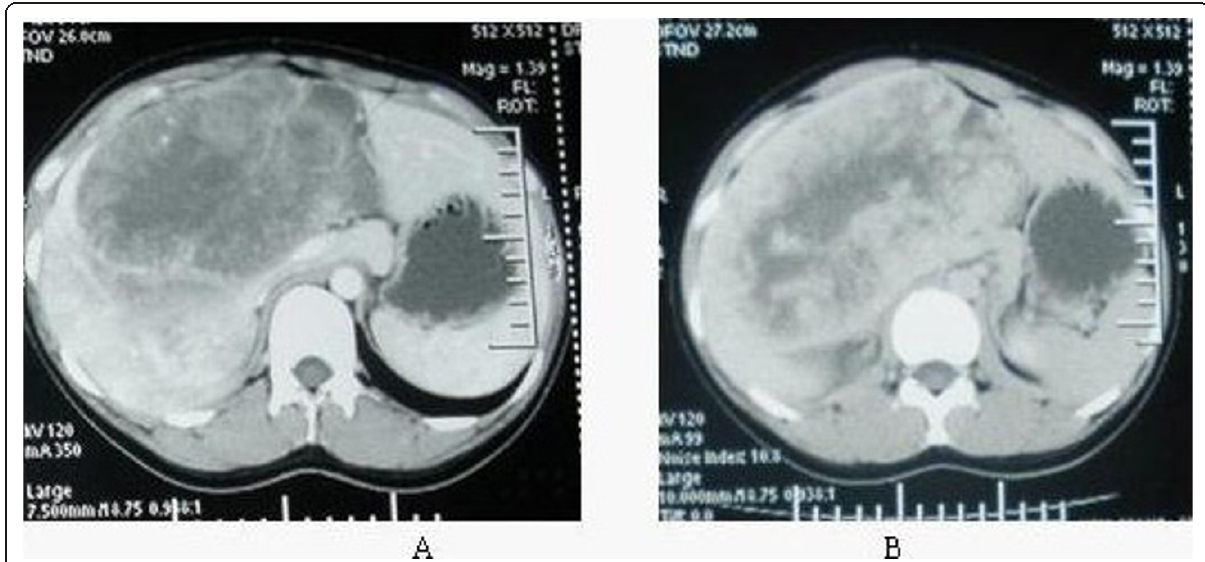
Figure 1 Enhanced CT scan before hepatectomy . A: Arterial phase image showing a large, heterogeneous mass of the liver with hypodense areas, which had clear border between tumor and the normal liver. Lesion showed heterogeneous enhancement and the high density of tumor blood vessels was seen in this region, lower density area to the central region as the center radial arrangement. Left hepatic vein was be compressed by the tumour and turned out to be rigidity. B: Venous late phase images showing a large, solid mass of the liver. Large hypodense tumor of the right hepatic lobe with an enhancement of the peripheral portion. The tumour was diffuse enhanced with a lager hypodense area in the center thought to be